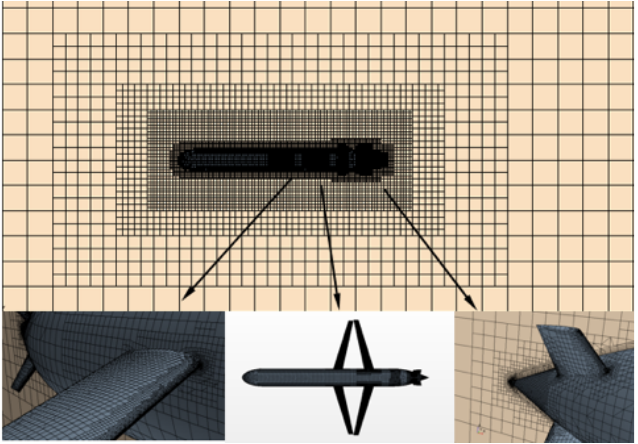
Figure 4. Mesh of the AUG.